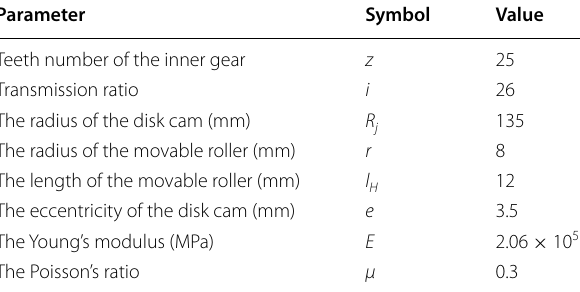
Table 1 Design parameters of CORR Parameter Symbol Value